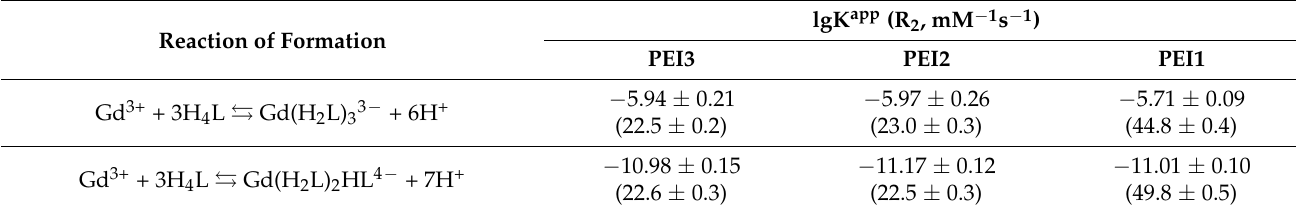
Figure 5. Dependence of relaxation effectiveness of the solutions containing Gd 3+ ions, citric acid, and polymer on acidity of medium at the constant content of citric acid in the presence of PEI (PEI0, PEI1, PEI2, or PEI3). C Gd(III) 0.5 mM, C H4L 1.5 mM, C PEI 5 mM ( a ) 10 mM ( b ). Table 3. Equilibria of formation reactions of gadolinium(III) tris-citrates formed in solutions of PEI of different molecular weight, their relaxivity, and the values of the apparent equilibrium constants (K app ).